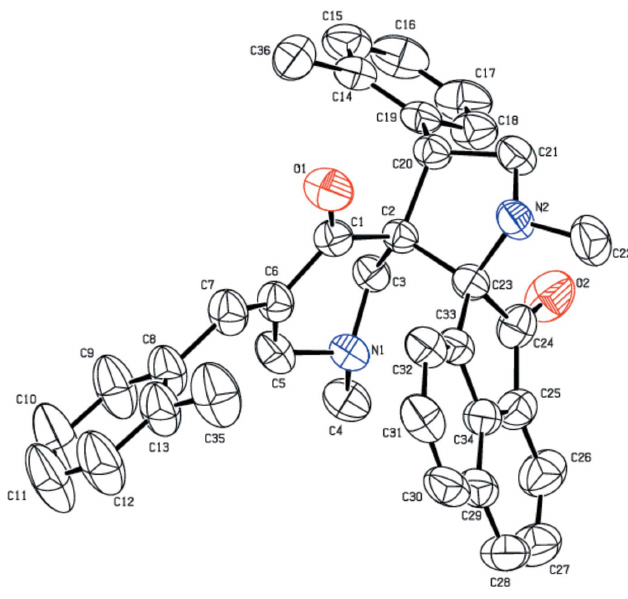
Figure 1 Displacement ellipsoid plot drawn at 50% probability level for (I) showing the atom-labelling scheme. H atoms have been omitted for